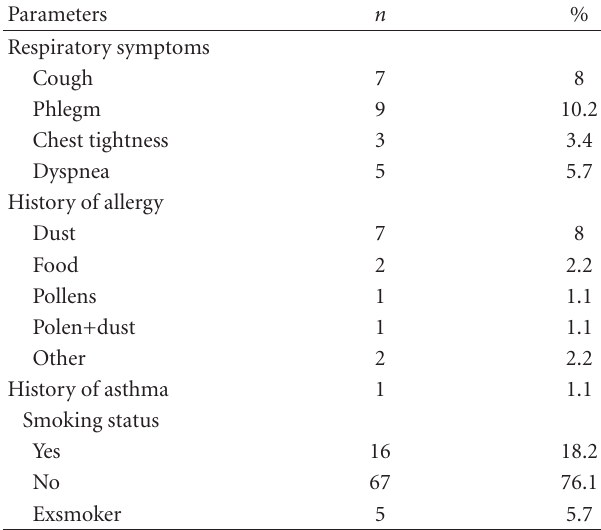
Table 1: Respiratory symptoms, smoking status, history of allergy, and asthma of workers.